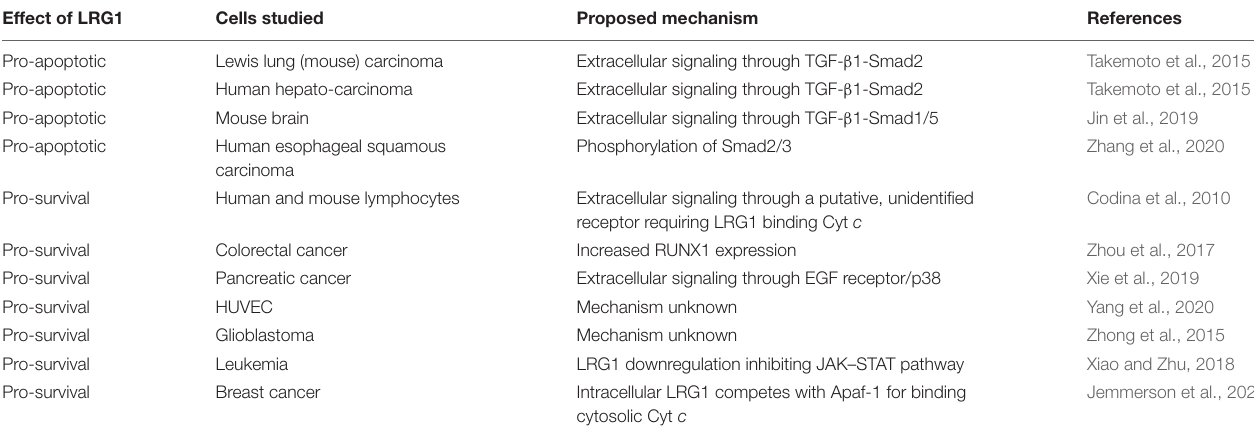
TABLE 1 | Evidence for pro-apoptotic and pro-survival functions of